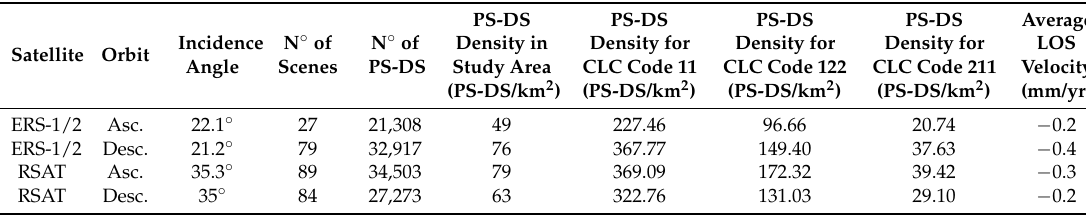
Figure 2. Average line of sight (LOS) velocity measured by the use of ERS-1/2 ascending ( a ) and descending ( b ) data (time interval from 1992 to 2000), and Radarsat ascending ( c ) and descending ( d ) data (time interval from 2003 to 2010). The reference point for each dataset is also reported. Table 1. Details on the SAR datasets, their processing, and